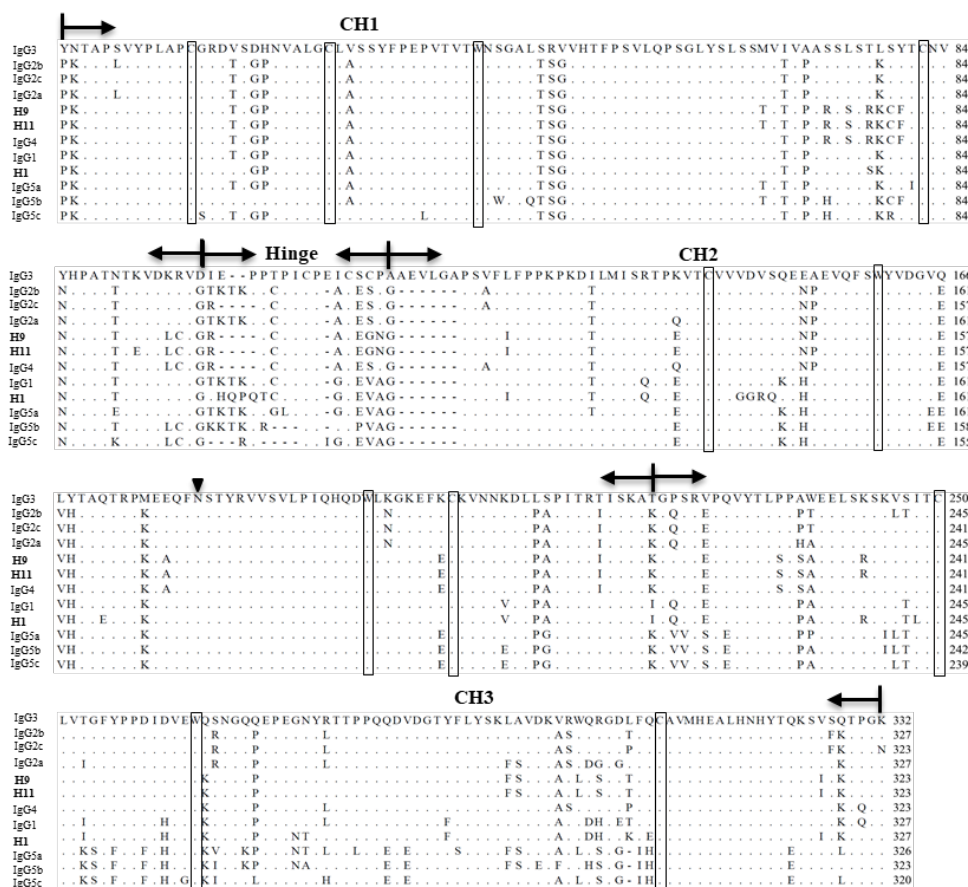
Figure 4. Comparison of the deduced amino acid sequences of H1, H9 and H11 with pig IgG subclasses. Dots indicate the same sequence and dashes indicate deletions. The conserved cysteines and tryptophans are boxed. An inverted triangle marks the conserved N-linked glycosylation site. Sequences of IgG subclasses were obtained from previous published data [23]. Table 2. Amino acid sequence identity matrix of H1, H9 and H11 constant regions with known pig IgG